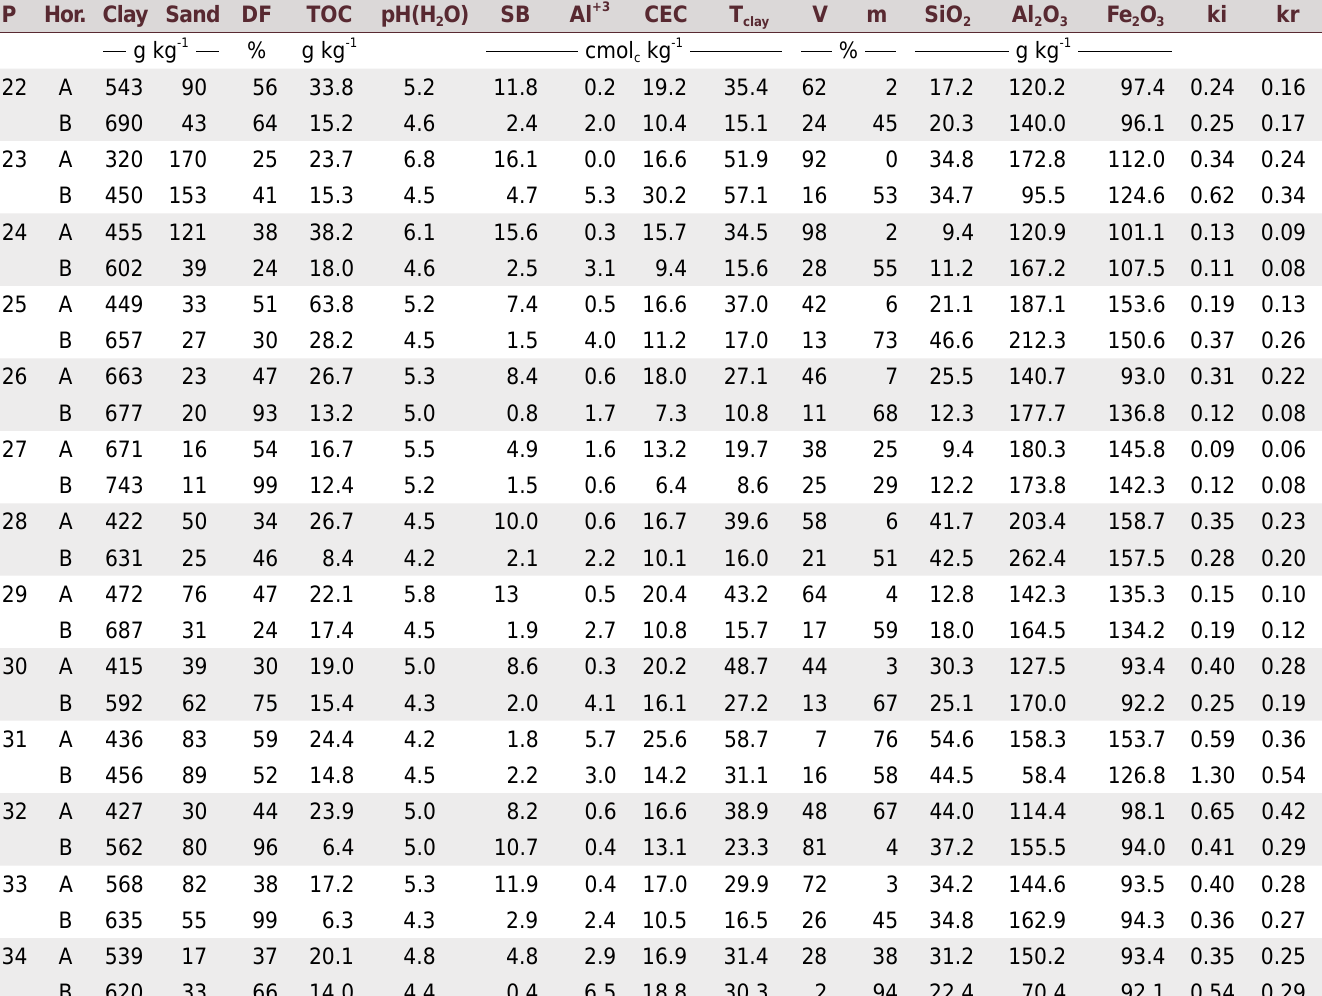
Table 4. Physical and chemical properties of A and B horizons of soil profiles (P) from region III (igneous basic rocks), located in Campos Novos, SC, Brazil P Hor. Clay Sand